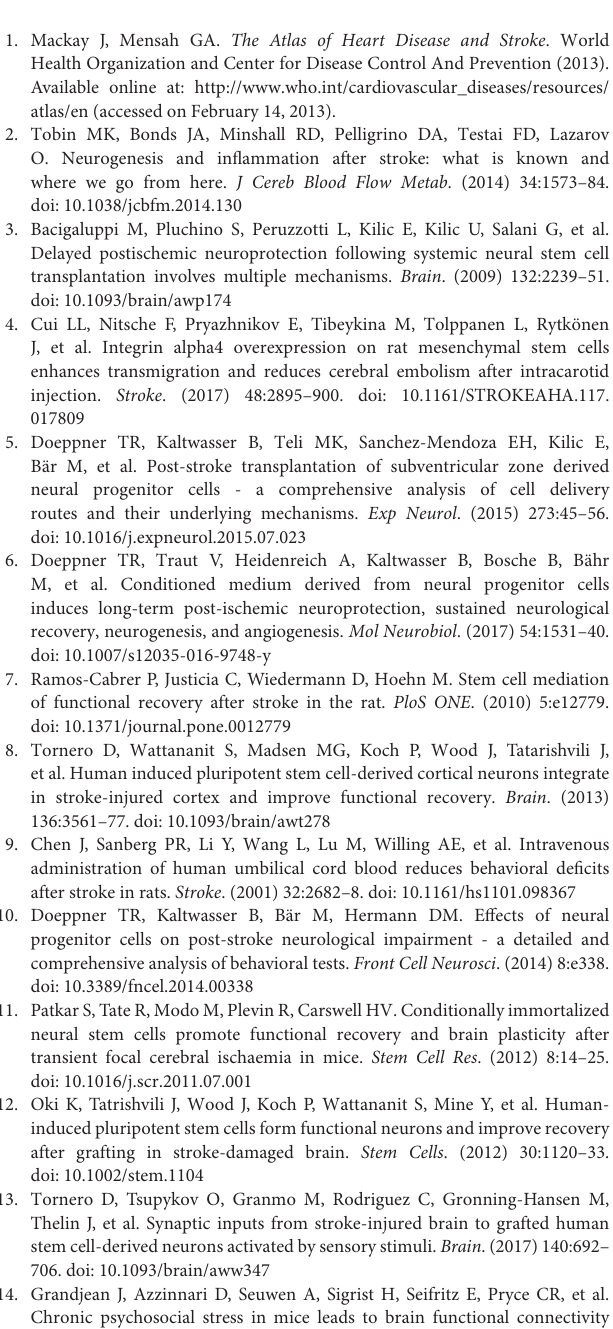
Supplementary Figure 1 | Overlay of regions of interest on MR images. The six regions analyzed on each hemisphere for analysis of functional network